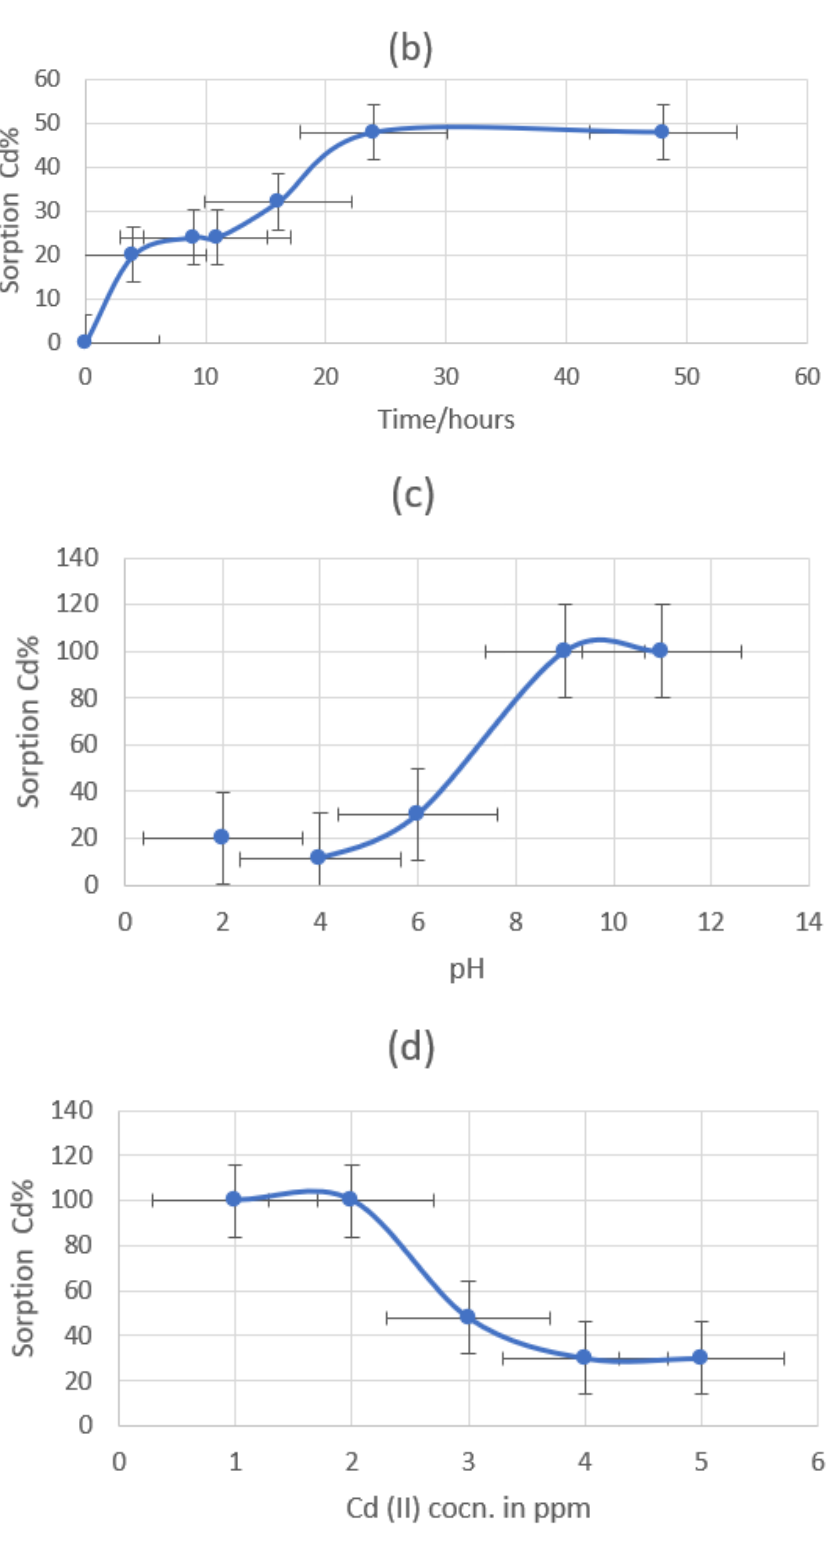
Figure 12. ( a ) Effect of the degree of grafting on the sorption of Cd(II) on polypropylene grafted membranes, ( b ) Effect of the contact time on the sorption of Cd(II) on polypropylene grafted mem- branes, ( c ) Effect of the hydrogen concentration on the sorption Cd(II) on polypropylene grafted membranes, and ( d ) Effect of the metal ion concentration on the sorption of Cd(II) on polypropylene grafted membranes.